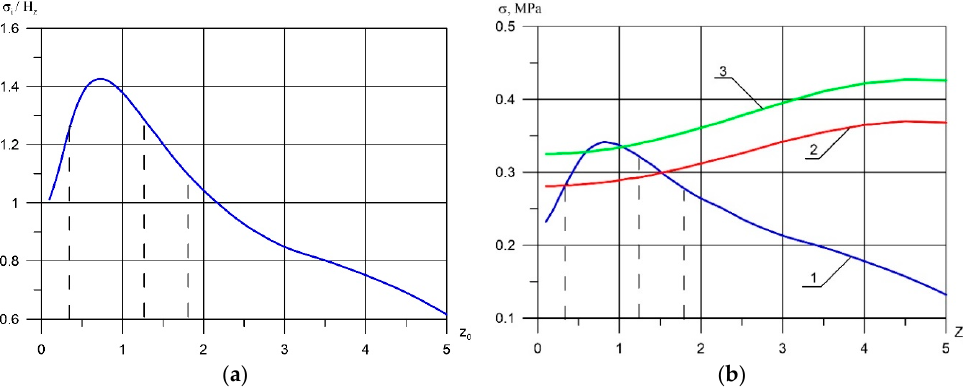
Figure 8. DCS CD ‐ 30 sample: a ) the amplitude of the ratio of octahedral stresses to hardness; b ) Figure 8. DCS CD-30 sample: ( a ) the amplitude of the ratio of octahedral stresses to hardness; ( b ) current current and permissible equivalent stress: (1) equivalent stress; (2) minimum allowable stress and permissible equivalent stress: (1) σ e equivalent stress; (2) σ Hke min minimum allowable stress according to the DCS criterion; (3) maximum allowable stress according to the DCS criterion. according to the DCS criterion; (3) σ Hke max maximum allowable stress according to the DCS